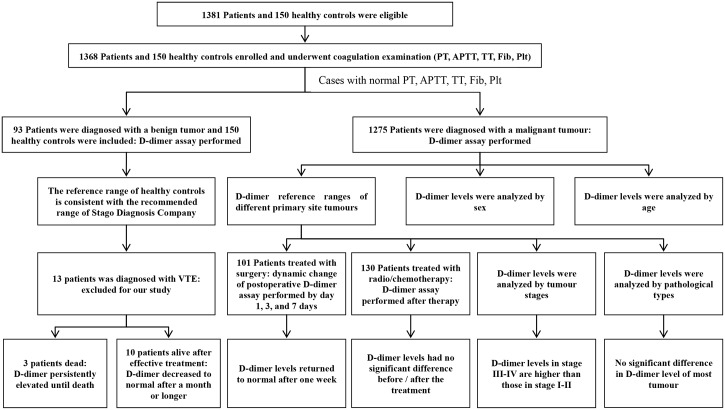
The diagram of the entire study.Enrolment and outcome.